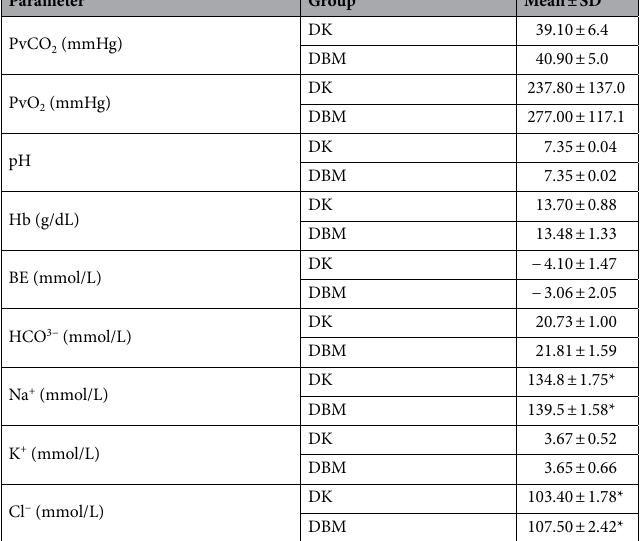
Table 3. Venous blood-gas values, venous pH, total haemoglobin, venous base excess, venous bicarbonate, and electrolytes in 20 Egyptian fruit bats anaesthetized for gonadectomy. Bats in group DK (n = 10) received DEX and KET combination and bats in group DBM (n = 10) received DEX, BUT and MDZ administration. Results are presented as mean ± standard deviation (SD). * Significant differences ( p < 0.05) between groups. PvCO 2 , PvO 2 , venous oxygen and carbon dioxide partial pressures; Hb, total haemoglobin; BE, venous base excess; HCO 3− venous bicarbonate; Na + ionized sodium; K + ionized potassium; Cl − ionized